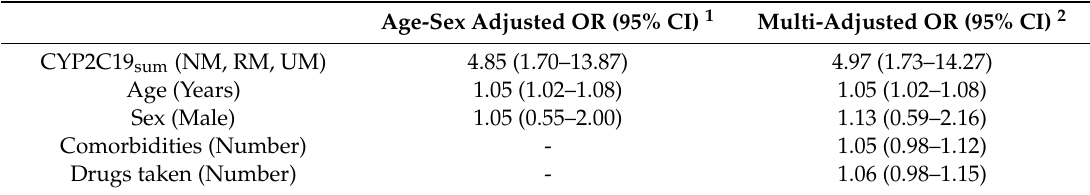
Figure 1. Differences in the metabolic phenotypes of CYP2C19 ( p = 0.020) for not suspecting clopidogrel (blue columns) and suspecting clopidogrel (orange columns). UM: ultra-rapid metabolizer; RM: rapid metabolizer; NM: normal metabolizer; IM: intermediate metabolizer; PM: poor metabolizer Table 3. Results of regression analyses for suspecting clopidogrel, based on the CYP2C19 enzyme